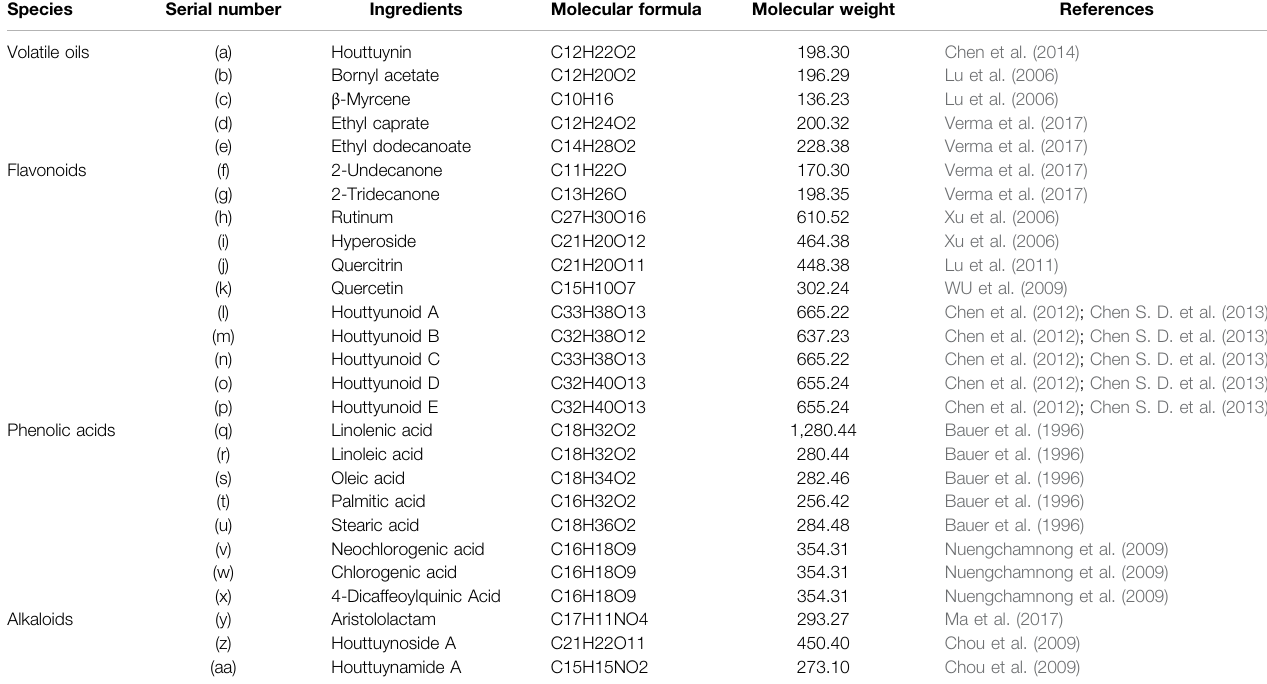
TABLE 1 | Important chemical compositions of Houttuynia cordata